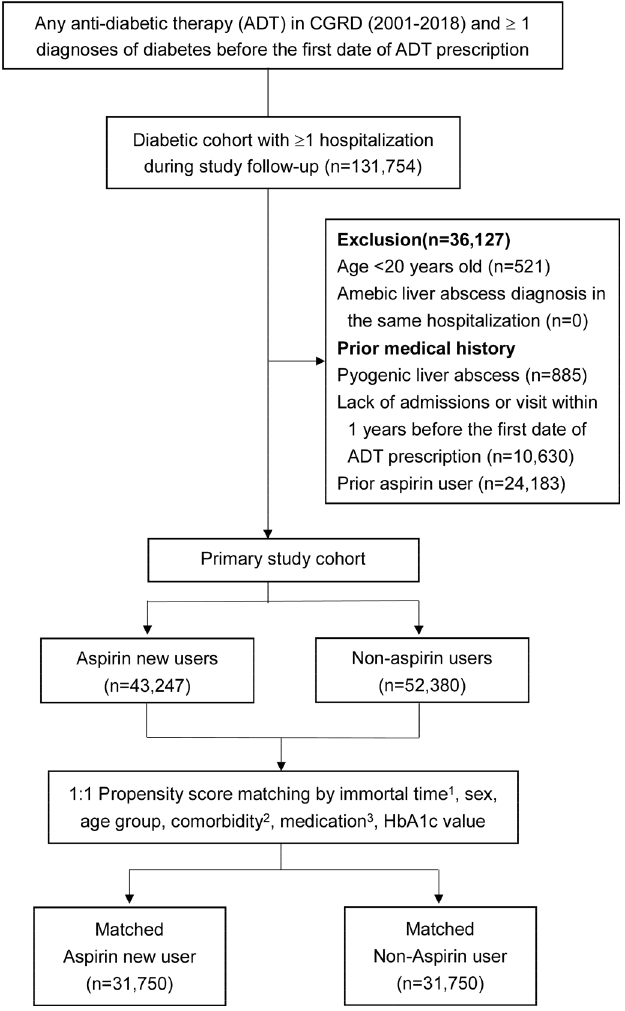
Figure 1. Flow chart of patient selection. 1. Immortal time: Patients who received aspirin were propensity matched in a 1:1 ratio with those who were not taking aspirin and were alive at the time of the first